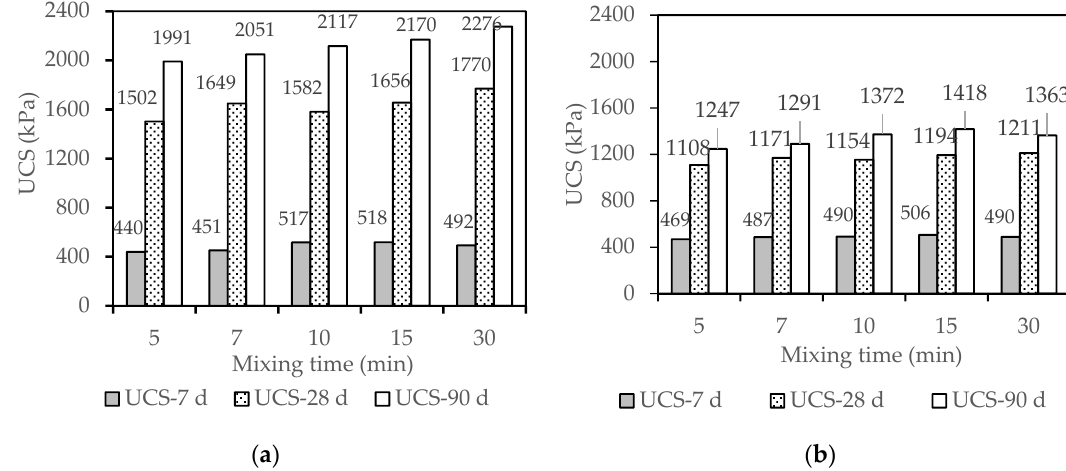
Figure 3. Effect of mixing time on ( a ) yield stress, ( b ) flow index and ( c ) infinite viscosity for CPB-T1 and CPB-T2 mixtures.